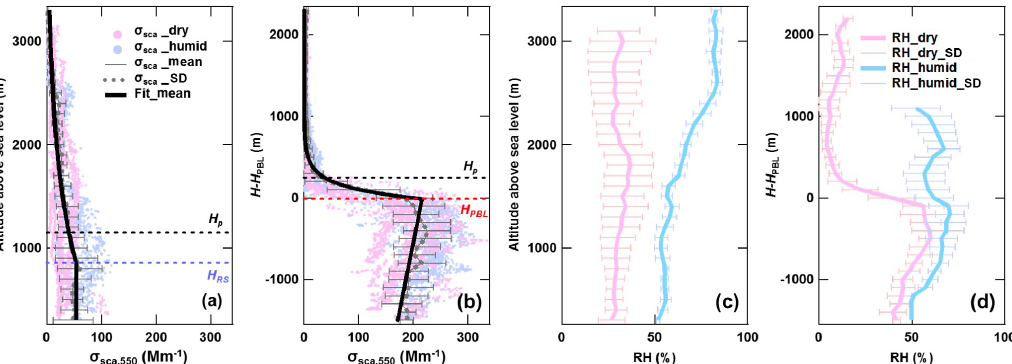
Figure 6. Mean vertical distributions of σ sca at 550nm (in Mm − 1 ) and relative humidity (%) during the flight campaign for those cases of (a, c) clean PBL and (b, d) pollution in the lower layer of the PBL where PBL heights have been normalized to the same altitude. Grey dashed lines represent mean σ sca vertical profiles, the light pink and blue dots represent 1s nephelometer-measured σ sca , under dry or humid conditions, respectively. Thick lines show the calculated fitting curves of the σ sca profiles (see Eqs. 8 and 9). Magenta and blue lines represent RH data collected under dry or humid conditions (c, d) . The horizontal error bars represent the standard deviations at every 100m